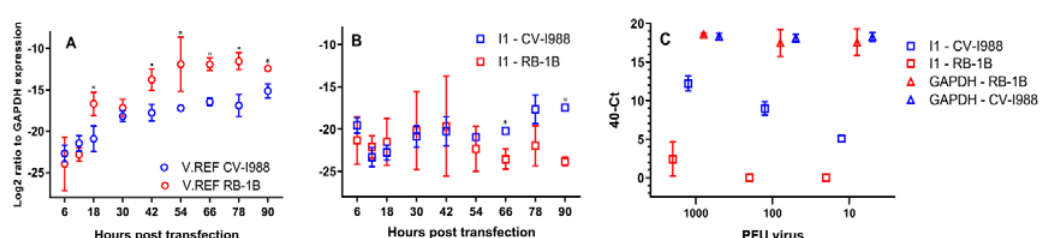
Figure 6. Panel A . Expression level of V.Ref in CEF cells transfected with bacterial artificial chromosome (BAC) DNA. Level of V.Ref was measured in cells harvested at time points 6, 12, 18, 30, 42, 54, 66, 78, and 90 h post-transfection. The expression levels of V.Ref were calculated and normalised to the corresponding levels for GAPDH and the ratios displayed on the graph for each time point. Three independent biological replicates were measured per time point. P -values were computed with a multiple t -test. P -values for the di ff erent time points were 0.5, 0.15, 0.04, 0.22, 0.03, 0.06, 0.007, 0.015, and 0.015. Panel B . Expression of I1 in CEF cells transfected with RB-1B or CVI-988 BAC DNA as a function of time. Cells were harvested at time points 6, 12, 18, 30, 42, 54, 66, 78, and 90 h post-transfection. Expression levels of I1 were calculated and normalised to the corresponding levels for GAPDH (see the Materials and Methods section ), and the ratios are displayed on the graph for each time point. Three independent biological replicates were measured per time point. P -values were 0.37, 0.29, 0.50, 0.81, 0.88, 0.41, 0.008, 0.06, and 0.00067. P -values were computed with a multiple t -test. Panel C . Expression level of GAPDH and I1 at 5 days post-infection in CEF cells infected with 1000, 100, or 10 PFU of MDV strains CVI-988 or RB-1B. Three independent biological replicates were measured per PFU value. Note that the x -scale is not continuous—there were only three discrete values corresponding to 1000, 100, and 10 PFU. In panels A and B , asterisks (*) indicate statistically significant data points.